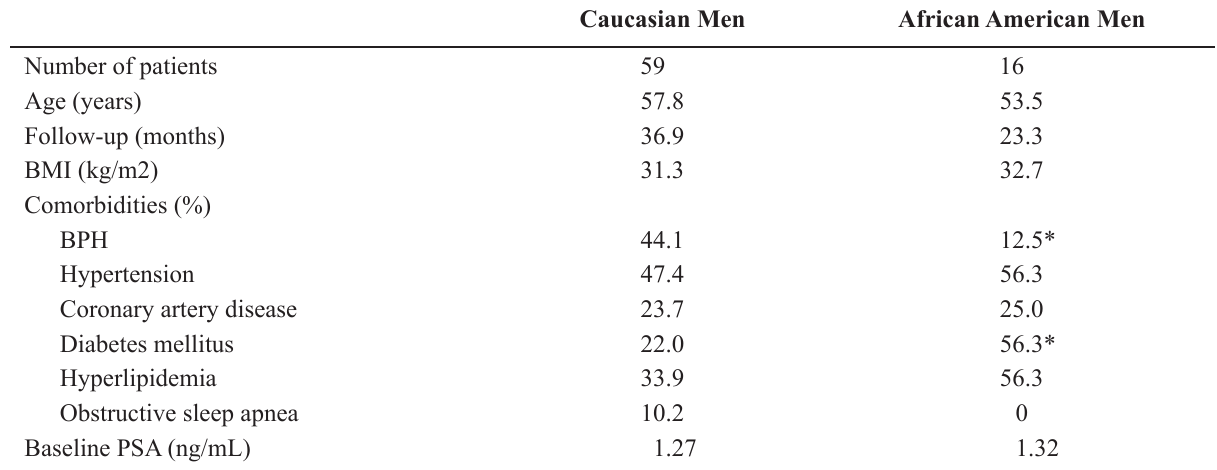
Table 1 – Patient characteristics.